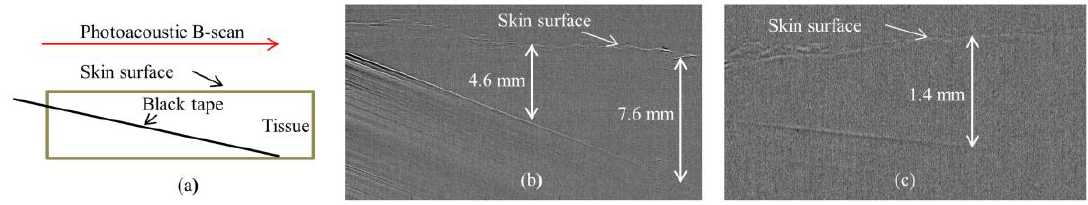
Figure 4. Single B-scan PA image of a black tape inserted obliquely in a chicken tissue. ( a ) Schematic diagram; ( b ) AR-PAM image; ( c ) OR-PAM image.